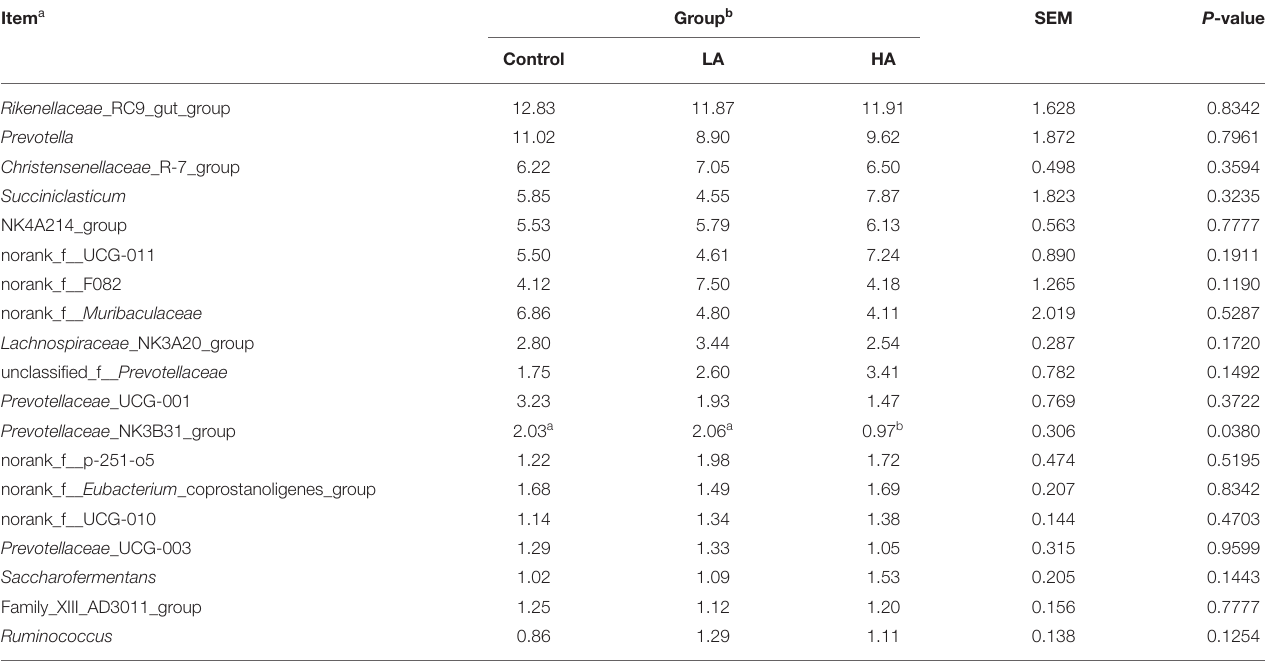
TABLE 7 | Effect of purple corn anthocyanin on the relative abundance of rumen dominant microflora at the genus level ( > 1%). Item a Group